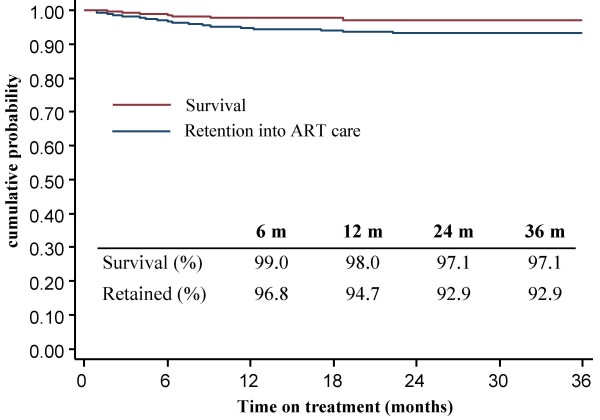
Kaplan Meier curve depicting the probability of survival or retention into the antiretroviral treatment (ART) program (n = 315). Children that had died or were lost to follow-up were considered as non-retained into ART care.